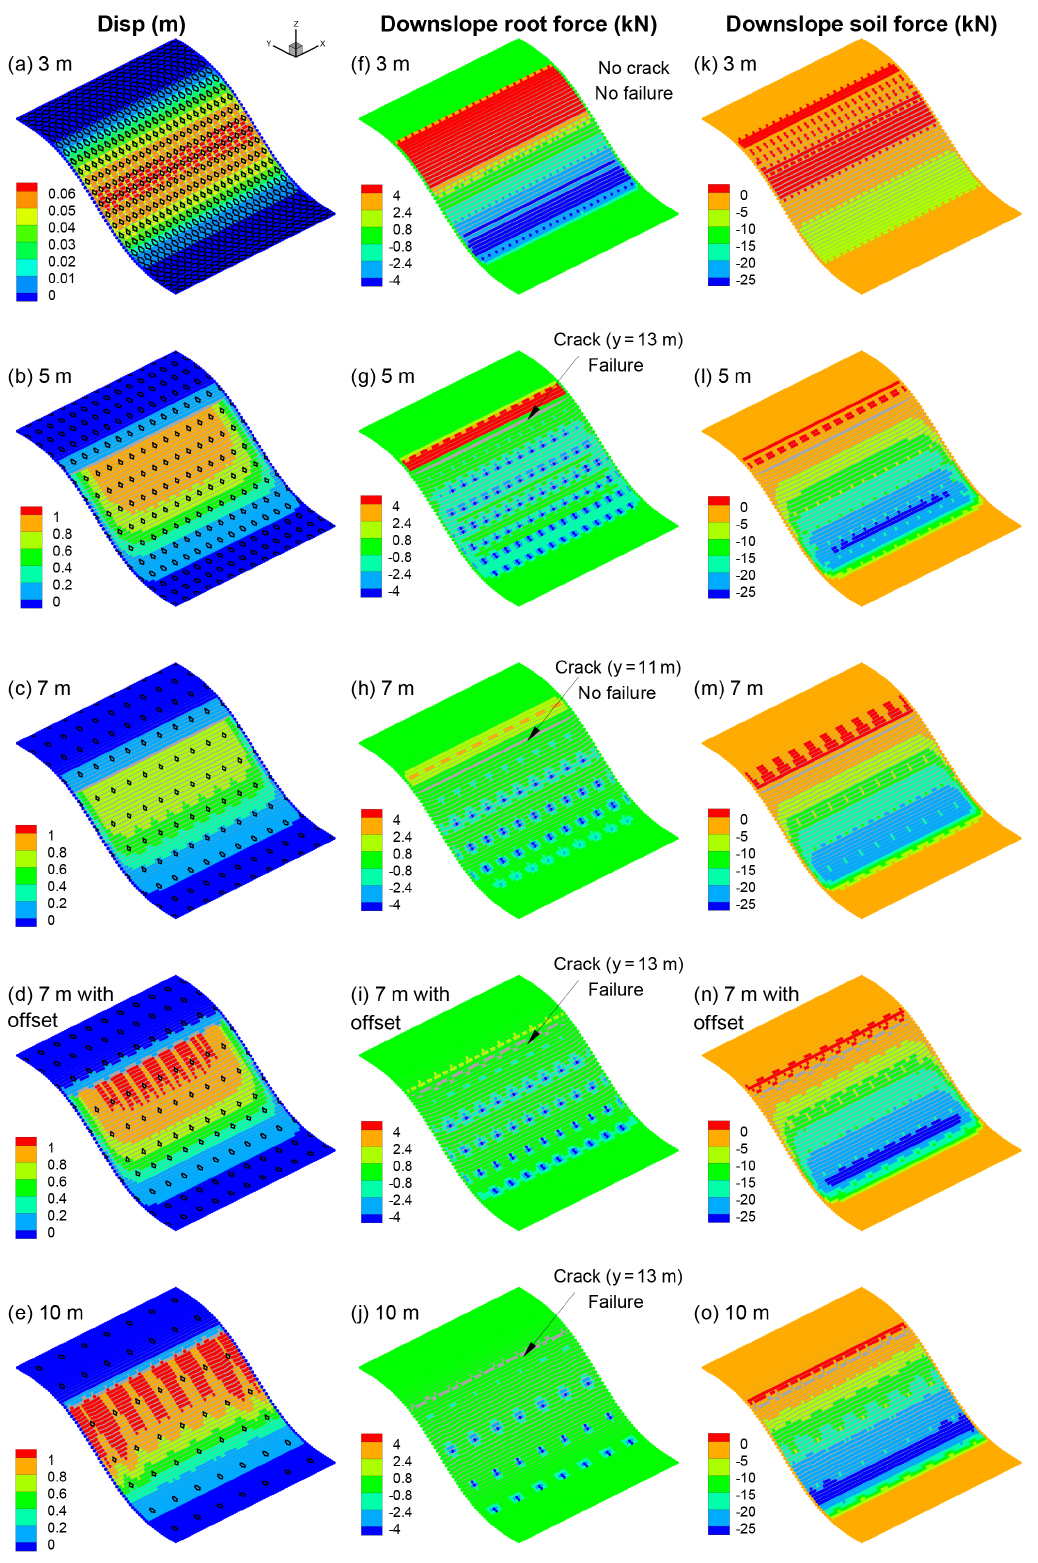
Figure 17. Effect of tree spacing on hillslope behavior. (a–e) Tree location (black circles) on the hillslope over slope displacement at the last stable time step or last time step for simulations where no landslide occurs (see Fig. 16). (f–j) Downslope root bond force. (k–o) Downslope soil bond force. Vertical crack position on slope shown in the column at